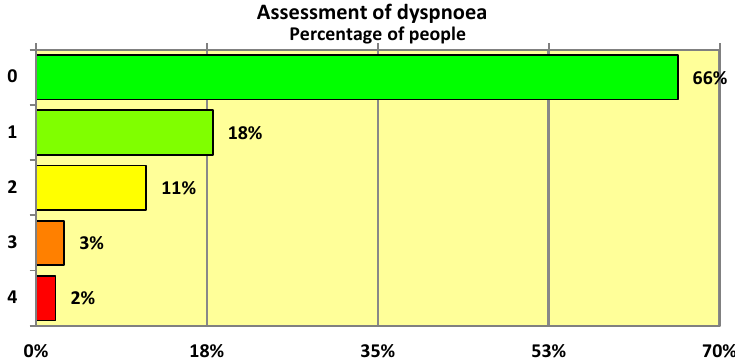
Table 4. Level of dyspnoea in persons infected with the SARS ‐ CoV ‐ 2 virus.